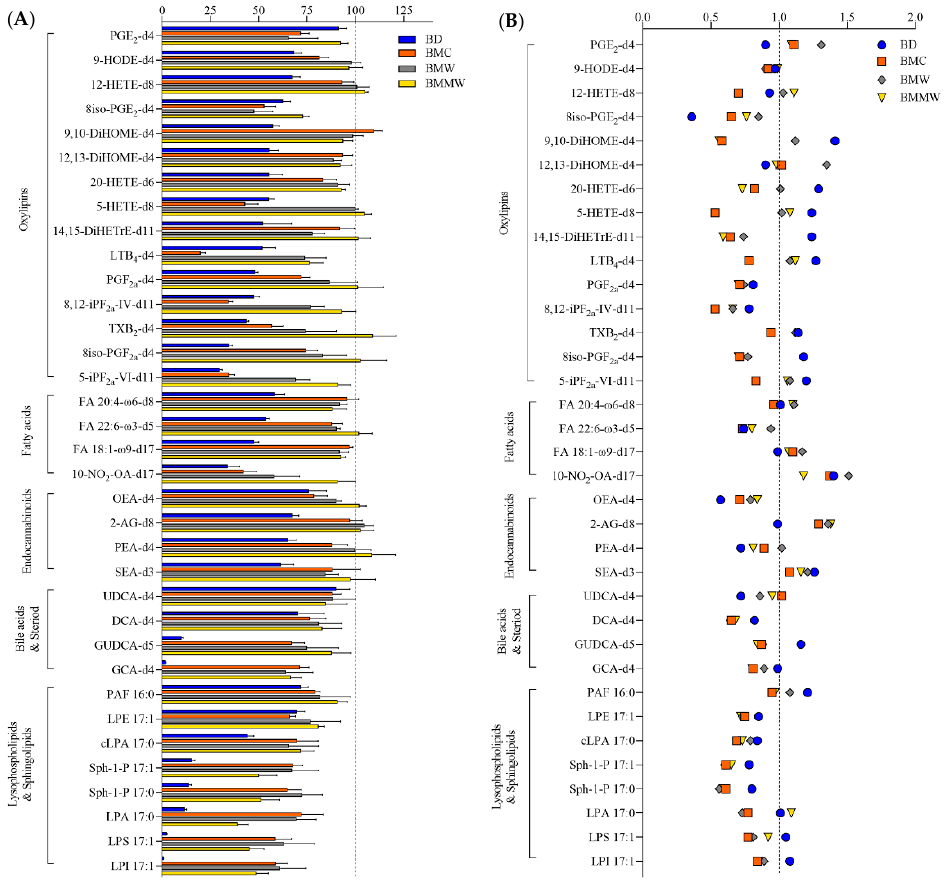
Figure 1. The ( A ) extraction recovery (%) and ( B ) matrix effect of lipids ISTDs by using the four extraction methods: BD, BMC, BMW, and BMMW. Lower recovery values of lysophospholipids and sphingolipids (<91%), and some bile acids, i.e., GCA-d4 (2–71%) and DCA-d4 (70–83%), were observed in all four extraction methods compared to other lipid metabolites. The reason for the lower yield might be because of the less non-polar properties of lysophospholipids and sphingolipids (logP = 2.6–5.4), GCA (logP = 1.4) and DCA (logP = 3.3) than the other classes of lipid metabolites,